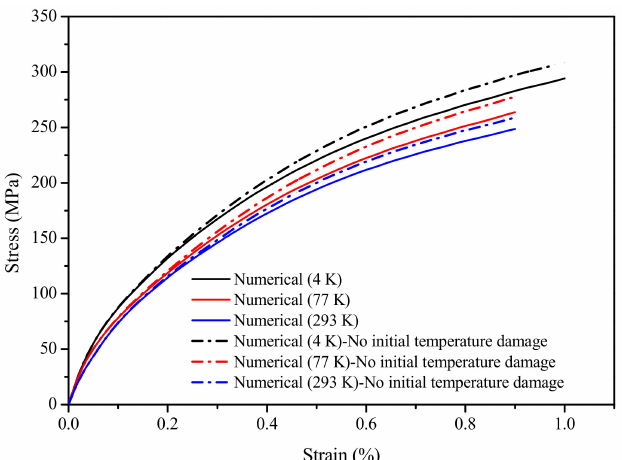
Figure 14. Numerical simulation stress–strain curves of EAS-Nb3Sn strand considering damage at different working